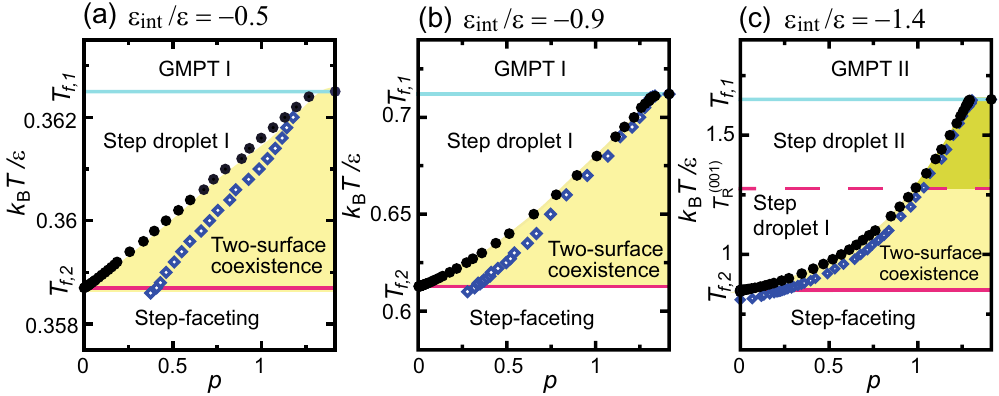
Figure 2. p – T faceting diagrams based on calculations using PWFRG (tensor network) method. Black filled circles: step assembling/disassembling points ( T f , p 1 ) . Open diamonds: spinodal points ( T f , p sp ) for homogeneous surfaces at temperature T f . The errors are within the size of the data markers. T f converges to √ 2 and p T f ,1 and T f ,2 for p T (GMPT I or GMPT II), the inclined surface 0 , respectively. For T f ,1 ≤ → → T f ,2 (step-faceting zone), is homogeneous and consists of elementary steps and locally merged steps. For T ≤ the inclined surface consists of (001) surfaces and a (111) surface. For T f ,2 < T < T f ,1 , the surface structure for p 1 < p is different from the structure for p < p 1 , where ( T f , p 1 ) is the first-order shape transition point. For p < p 1 , the inclined surface consists of a homogeneous slope; whereas, for p 1 < p , the inclined surface consists of a (111) surface and “terrace” surfaces with a slope p 1 . For p 1 < p < p sp , the inclined surface can have a 0.5 . ( b ) ε int /ε 0.9 . ( c ) ε int /ε 1.4 . Broken homogeneous slope p as a metastable surface. ( a ) ε int /ε = − = − = − ( 001 ) /ε 1.28 , dividing the step droplet zone into two line: roughening transition of the (001) surface T R = (cid:31) ( x η ∗ where ∗ , y ∗ ) is (cid:31) η at the two-surface coexistent point. � = − Faceting diagrams. Figure 2 shows p – T faceting diagrams calculated by the PWFRG (tensor network) ( 001 ) method. Figure 2a,b show the diagrams for T < T R , while the diagram in (c) includes the temperature range < T . The light blue and the red lines in the diagrams show the zone boundaries T f ,1 and T f ,2 , respectively, T ( 001 ) R ( 001 ) ε int /ε 1.4 . The black circles are the transition points calculated and the red broken line in (c) shows T R for = by the PWFRG method, and can be denoted by ( p 1 , T f ) . As seen from Fig. 2a, the phase separation points (black circles) are almost lined up to form the phase separa- 0.5 . On the other hand, the phase separation lines are concave for ε int /ε 0.9 and −1.4 tion line for ε int /ε = − = − in (b) and (c). In the step droplet I zone, at temperatures lower than the phase separation points, the inclined T and a faceted macrostep with a surface at ( p , T ) consists of a “stepped” surface with a slope p 1 ( < p ) at T f = (111) side surface (two-surface coexistence); whereas at temperatures higher than the phase separation points, the inclined surface consists of (001) terraces, elementary steps, and locally merged macrosteps with a (111) side surface. In the step droplet II zone (Fig. 2c), the (001) terraces and elementary steps are not well defined because the (001) surface is rough. However, the negative steps, which are (111) terraces and steps with (001) side surfaces, are well defined because the roughening temperature for a (111) surface in the RSOS model is infinite. It appears that p 1 jumps at T f ,1 around √ 2 . We consider that the jump occurs because of the terrace-step-kink (TSK) characteristics. The inclined surface near the (111) surface has a structure close to an ideal TSK due to the RSOS restriction 35 . We will return to this phenomenon in the “Discussion” section. Spinodal points. In the step droplet zone, we can calculate surface tension for the metastable surface 17,50,51 , illustrated by the dotted line in Fig. 1e. The end of the dotted line, where the calculated slope in the PWFRG η sp , approximately gives a spinodal point. We designate the slope at method jumps to √ 2 (the (111) surface) at (cid:31) η sp gives p sp η sp ) p ( the spinodal point by p sp . The slope at . (cid:31) = |� � | In Fig. 2, p sp are shown by open blue diamonds. At a given T , in the region p 1 < p < p sp , an inclined surface can exist without a macrostep as a metastable structure. The metastable region is found to be wider for smaller ε int . This metastable surface can appear when the surface is quenched from a high temperature T f ( p ) < T to | | a lower temperature T ′ < T f ( p ) with p < p sp ( T ′ ) . For the (111) surface, we obtained spinodal points where the ( 111 ) ( 111 ) slope jumps from √ 2 to p sp < p 1 or 0 at η sp < η ∗ as η decreases. Hence, for changing η , the change in slope p draws a hysteresis curve, as for a magnet. The magnetic field H corresponds to η , and the magnetisation M corresponds to p 19 .